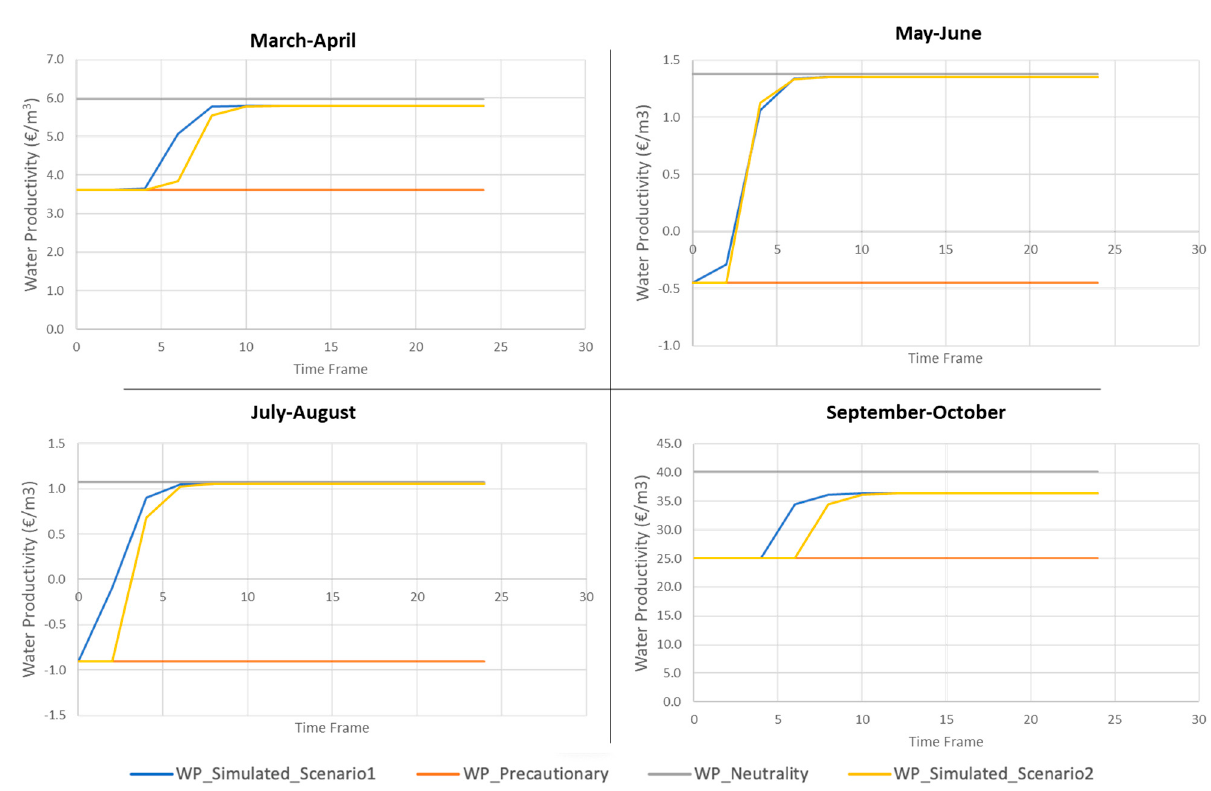
Figure 9. WP over time.